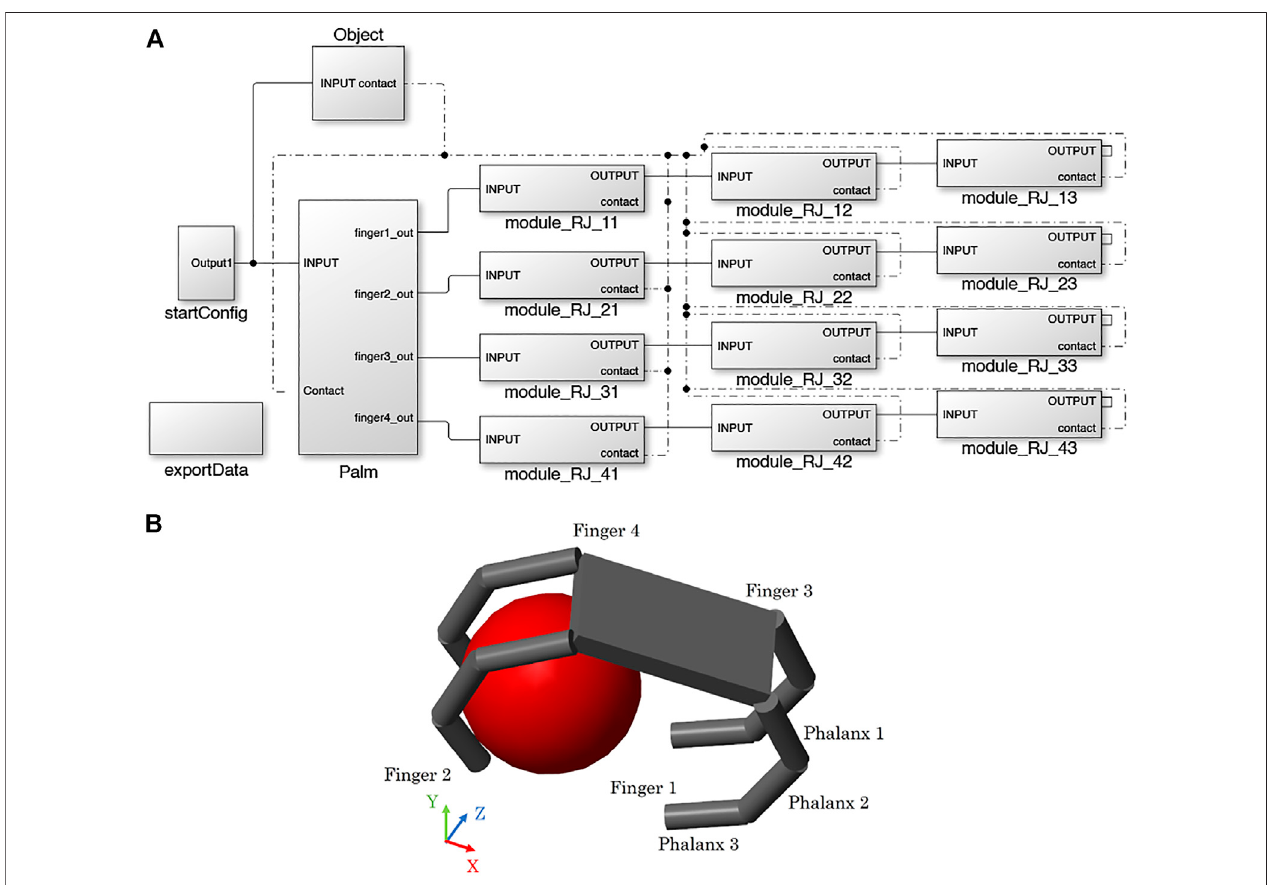
FIGURE 5 | Four fi ngered gripper grasping a sphere: block scheme (A) and structure (B) .